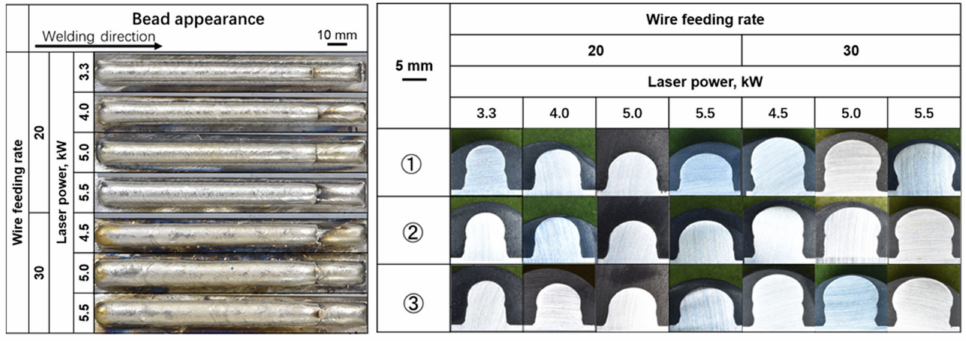
Figure 17. Bead appearances and cross-sections ( V p = 0.3